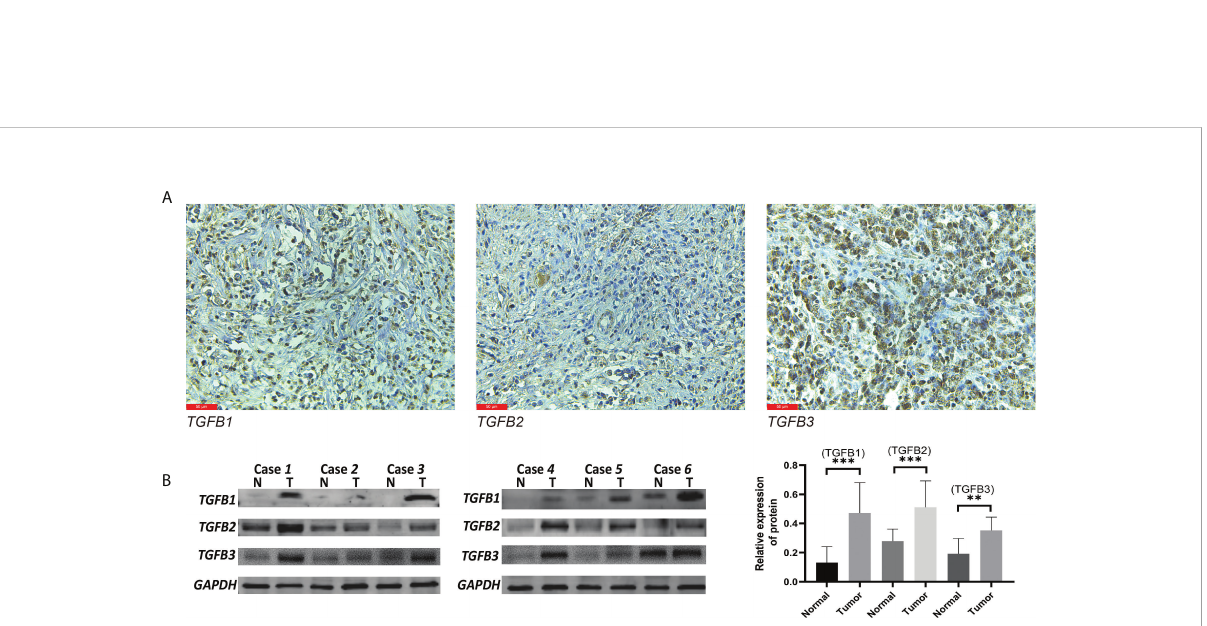
FIGURE 3 TGF b protein level detection. Western blot (A) and IHC (B) validation of TGF b 1, TGF b 2 and TGF b 3 proteins in gastric cancer tissues. ** P < 0.01; *** P <